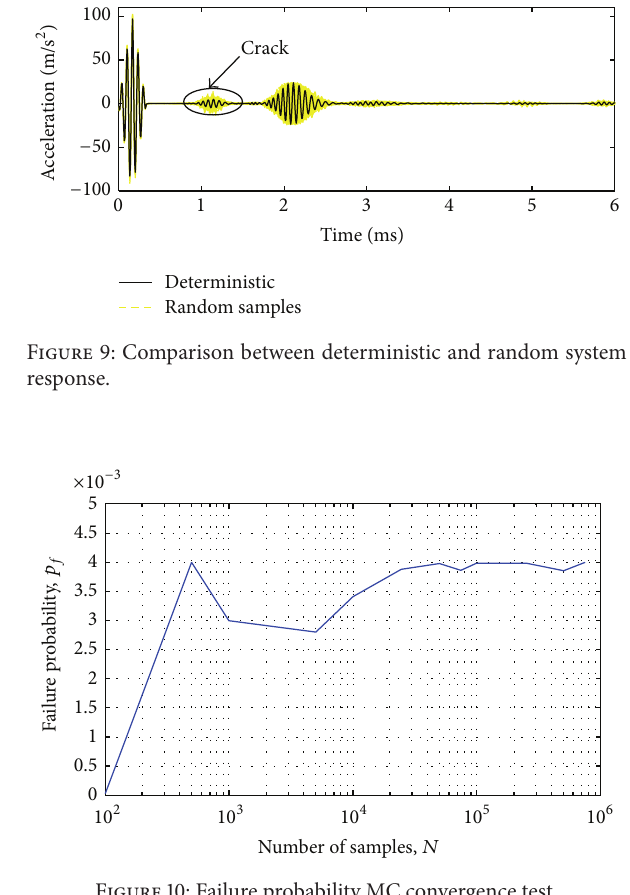
Figure 10: Failure probability MC convergence